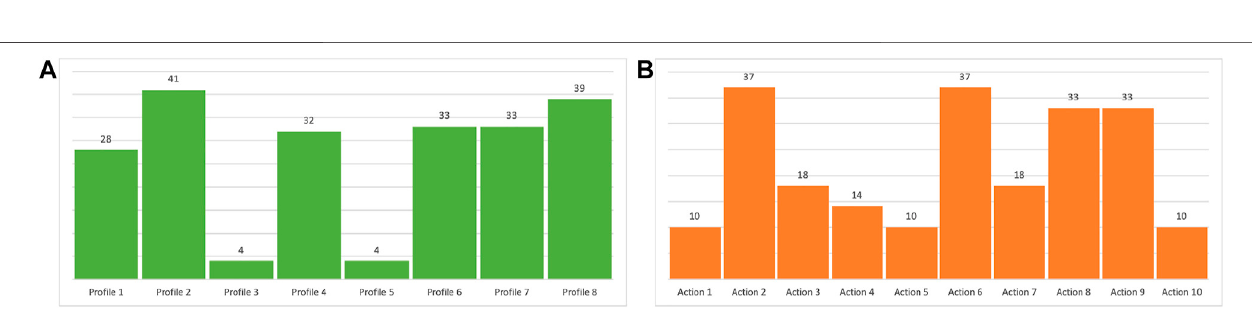
FIGURE 6 | Charts show (A) inferred (cumulative) impairment state of patients and; (B) inferred impact of known actions on patients.